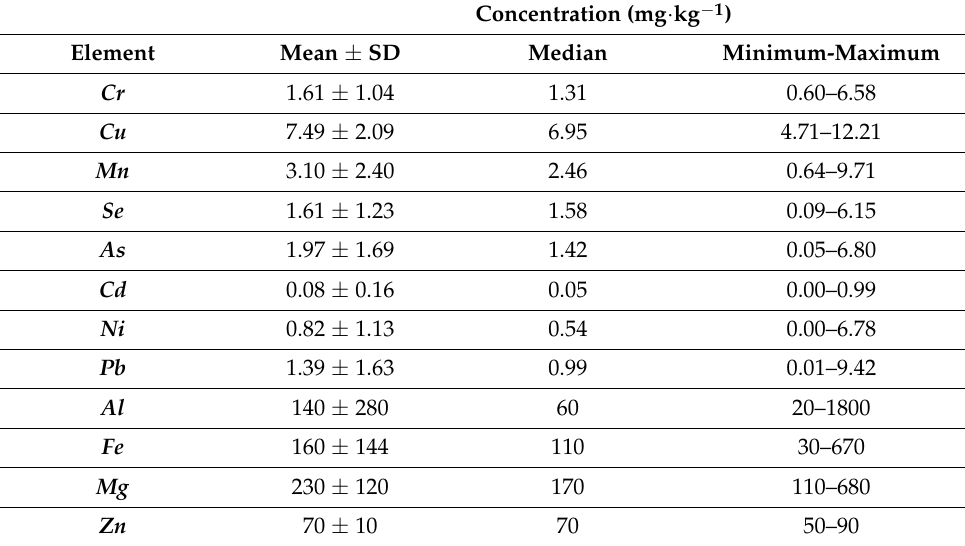
Table 4. Average concentrations of trace and toxic elements.